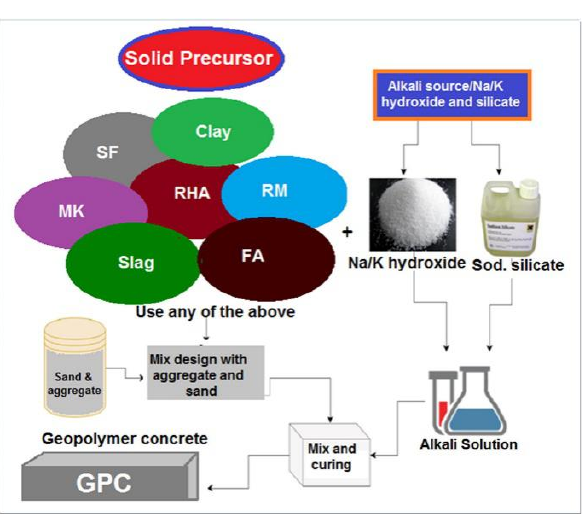
Figure 7: Geopolymer mixing process [49]